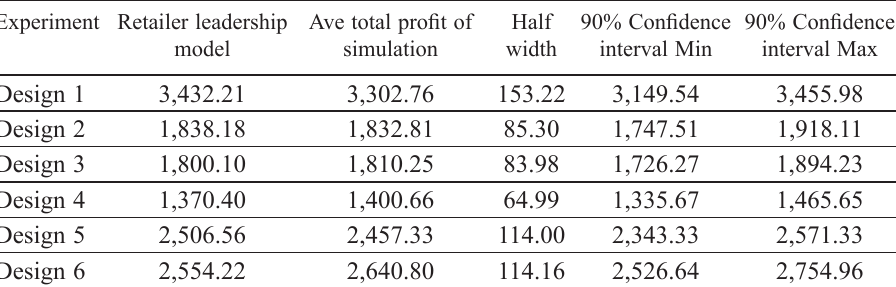
Table 11. Model verification results in 17 experiments